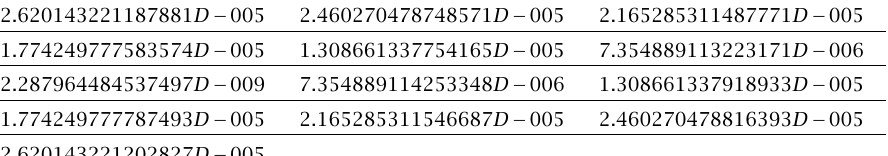
Table 3.11 . The errors with n = 13 , l = 0 . 25 on γ 1 .